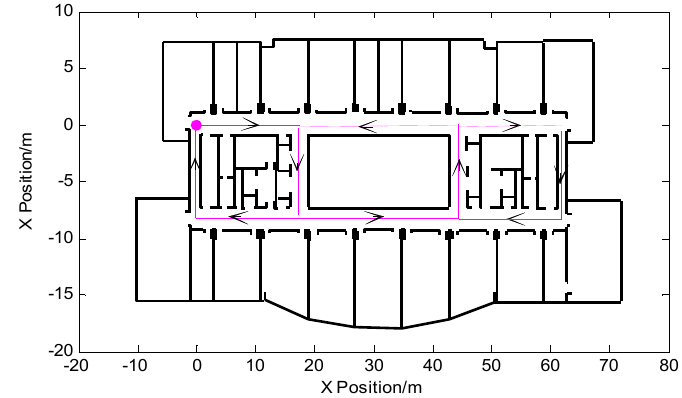
Figure 11. Experimental site and preset walking path.